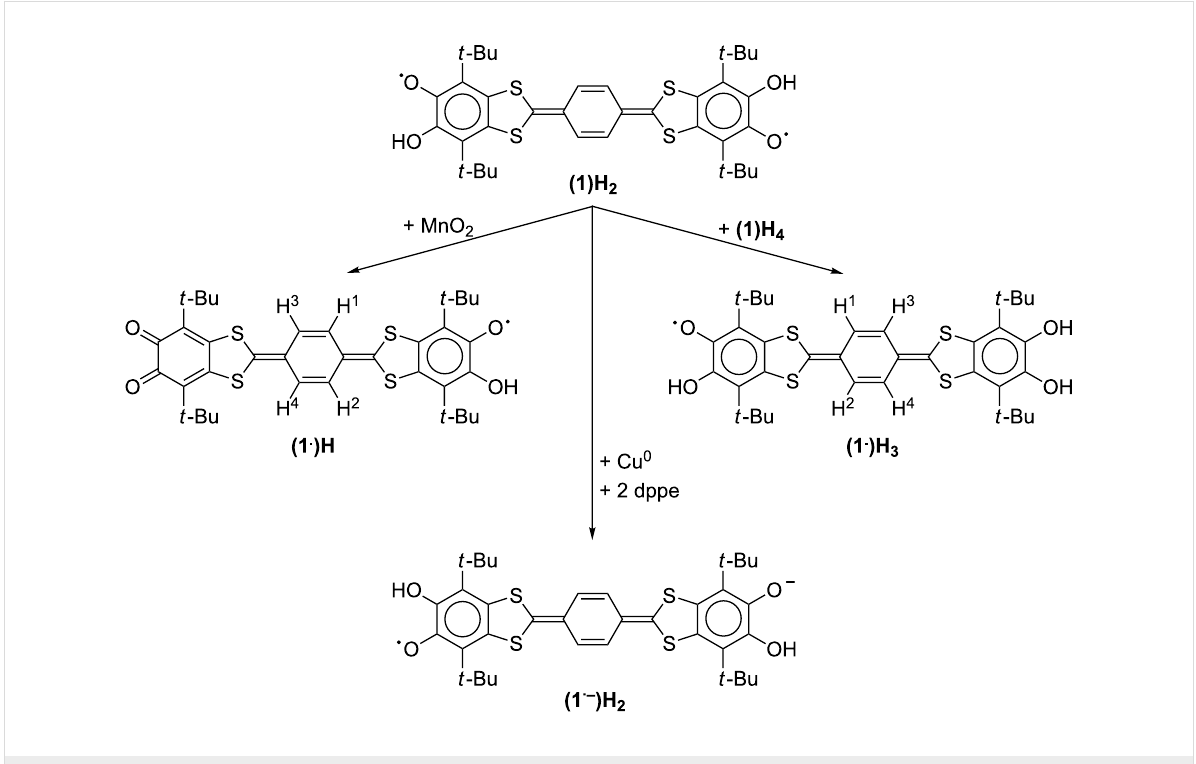
Scheme 2: Paramagnetic reduced protonated derivatives of the quinone 2